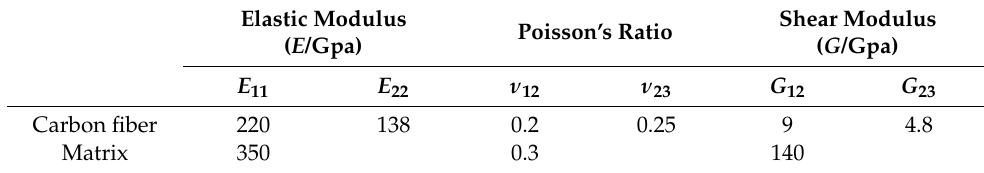
Table 3. The material parameters of components.